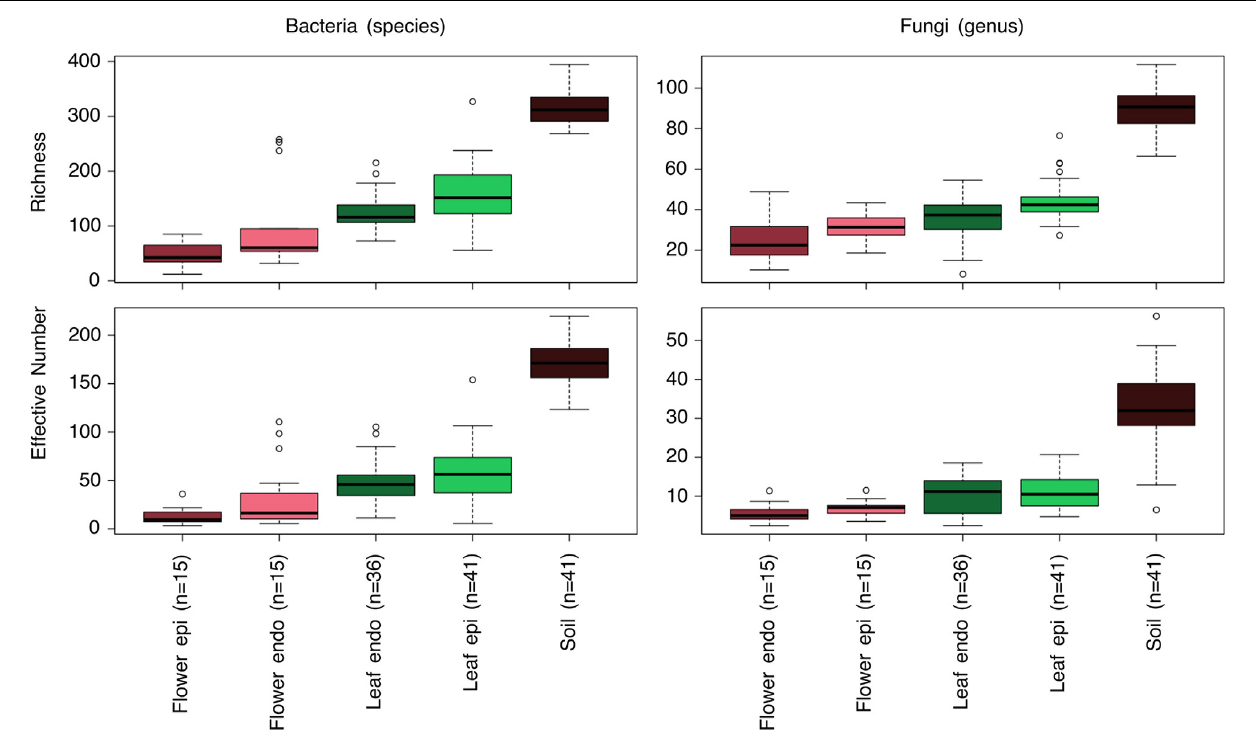
FIGURE 2 | Box-Whisker plots of Richness and Effective Number diversity of bacterial and fungal epi- and endophytic communities of the flower and leaf compartments as well as soil of Achillea and leaf and soil of Hamamelis . Given are mean values, quantiles 2 and 3 (box) and 1 and 4 (lines) and outliers ( < 5% and > 95% of the mean). In parenthesis: number of samples. Samples were subsampled (repeatedly rarefied to 1,000 sequences) for comparison. For statistical comparisons of these data see Supplementary Table 1 .